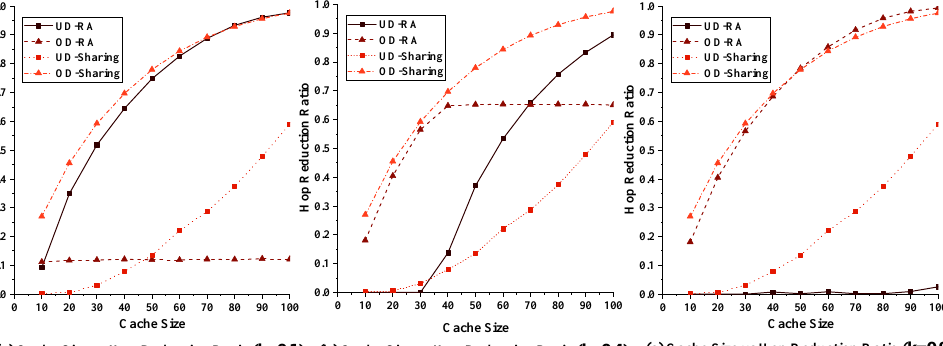
Figure 5. Caching performance vs. cache size in terms of: cache hit ratio.